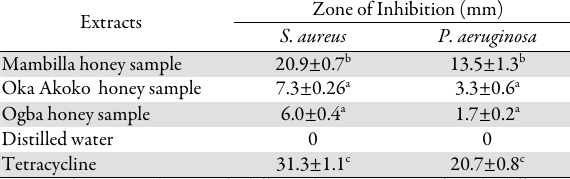
Table 2. Antibacterial results of honey